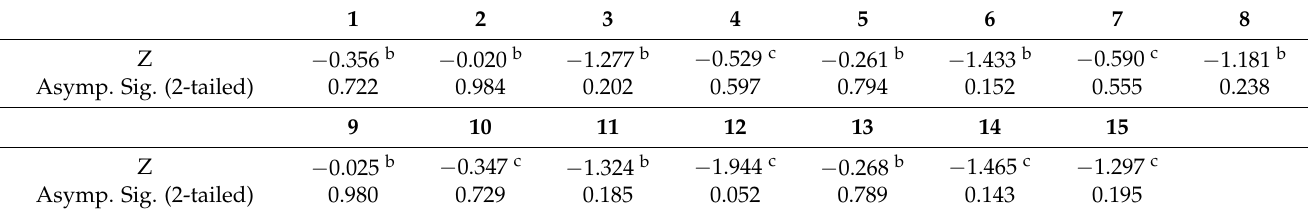
Table 4. Wilcoxon signed-rank test. ( a ) Wilcoxon signed-rank test, ( b ) based on negative ranks, ( c ) Based on positive ranks.